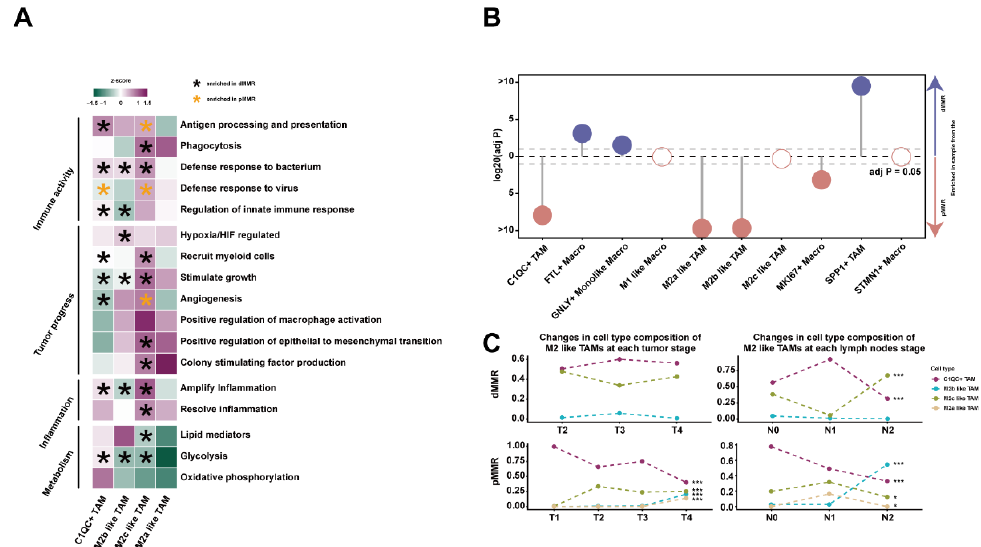
Figure 2. Analysis of macrophage functions and cell ratios: ( A ) the heatmap shows the Gene Set Variation Analysis (GSVA) z ‐ score of the functional activity of M2 ‐ like TAMs. These functions were classified into four categories according to the different gene set characteristics. The green color indicates that the activity of this function or pathway is upregulated in TAMs, and the purple color indicates that the activity of this function or pathway is downregulated in TAMs. The asterisk indicates that one function is significantly upregulated in dMMR or pMMR; ( B ) the lollipop plot shows the infiltration of 10 clusters of macrophages in dMMR and pMMR. Solid circles indicate that this cluster of macrophages is significantly enriched in dMMR or pMMR (chi ‐ square test, p < 0.05), and hollow circles indicate no significant difference in cell ratios between dMMR and pMMR ( p > 0.05); ( C ) changes in the cell ratios of M2 ‐ like TAMs in dMMR and pMMR at different tumor stages (T1,